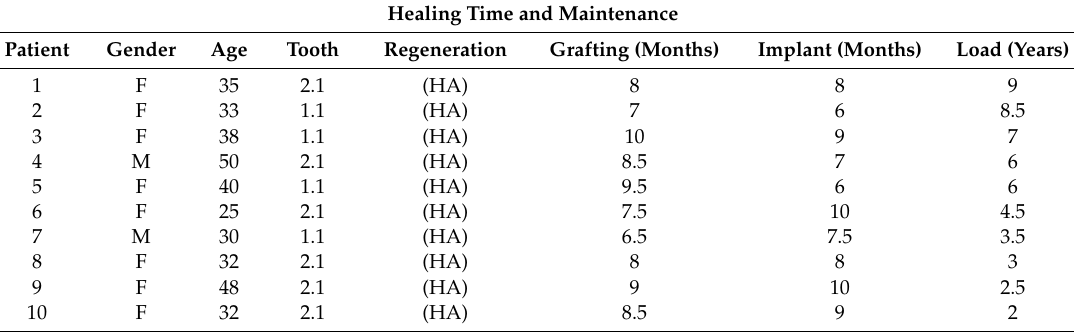
Table 3. Patient characteristics and surgical sites treated with horizontal / vertical augmentation in the nasopalatine canal.